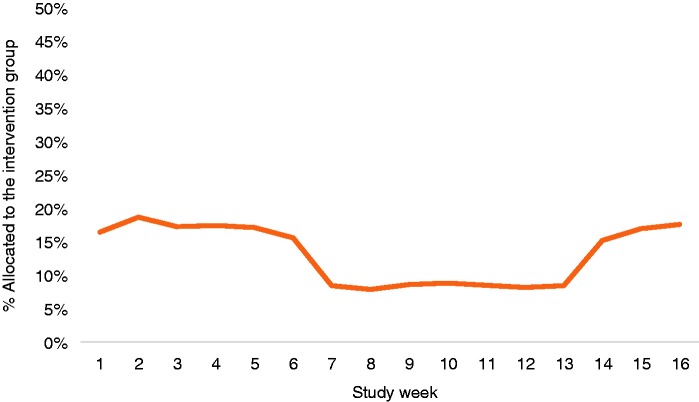
Plot of the proportion allocated to the intervention group by week at
which users entered the study. The x-axis represents study week; the
y-axis represents the proportion allocated to the intervention
group.